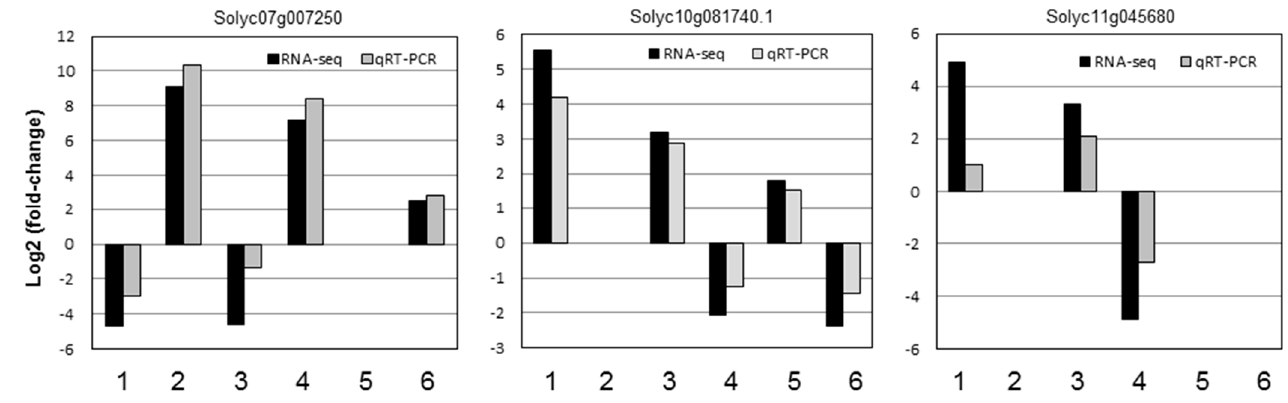
Figure 5. qRT-PCR analysis of DEGs in the seven comparative groups. 1, “H 2 O1h vs. MgO1h”; 2, “H 2 O7d vs. MgO7d”; 3, “H 2 O7d vs. H 2 O7d + FOL1h”; 4, “MgO7d vs. MgO7d + FOL1h”; 5, “H 2 O7d vs. H 2 O7d + FOL21d”; 6, “MgO7d vs. MgO7d + FOL21d”.